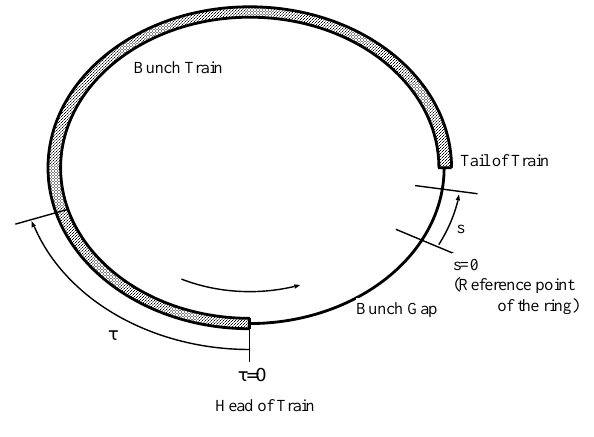
FIG. 7. Definition of parameters s and t .